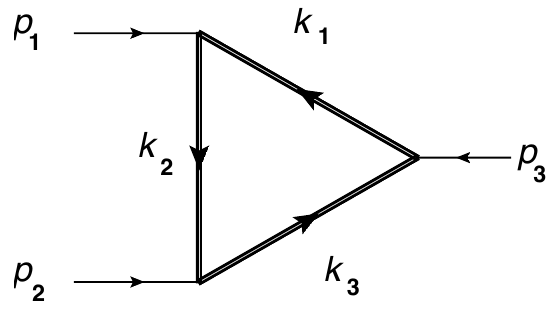
Figure 11 . The one-loop scalar triangle. Thick double lines denote massive